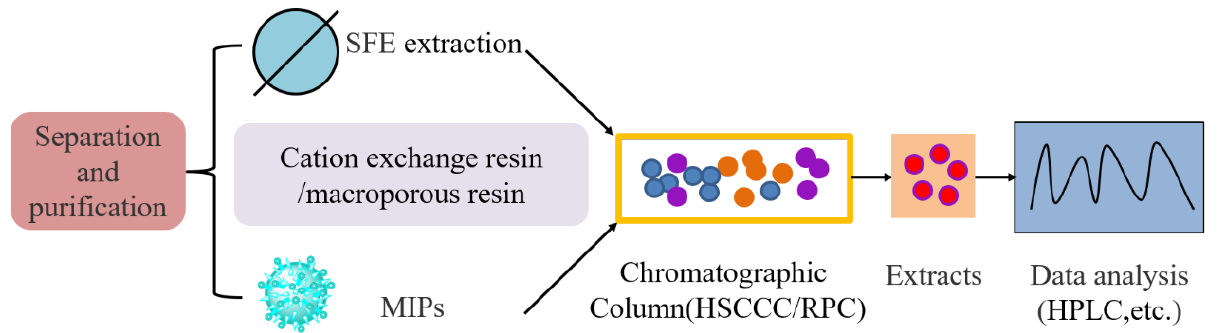
Figure 4. Schematic diagram of COR separation, purification and detection. SFE and MIPs techniques were used to separate the fruiting bodies of solid fermentation or the fermentation broth of liquid fermentation. HSCCC/RPC techniques were used to separate and purify the crystallization of the crude samples, and then the COR samples were detected and analyzed by high-performance liquid chromatography (HPLC).